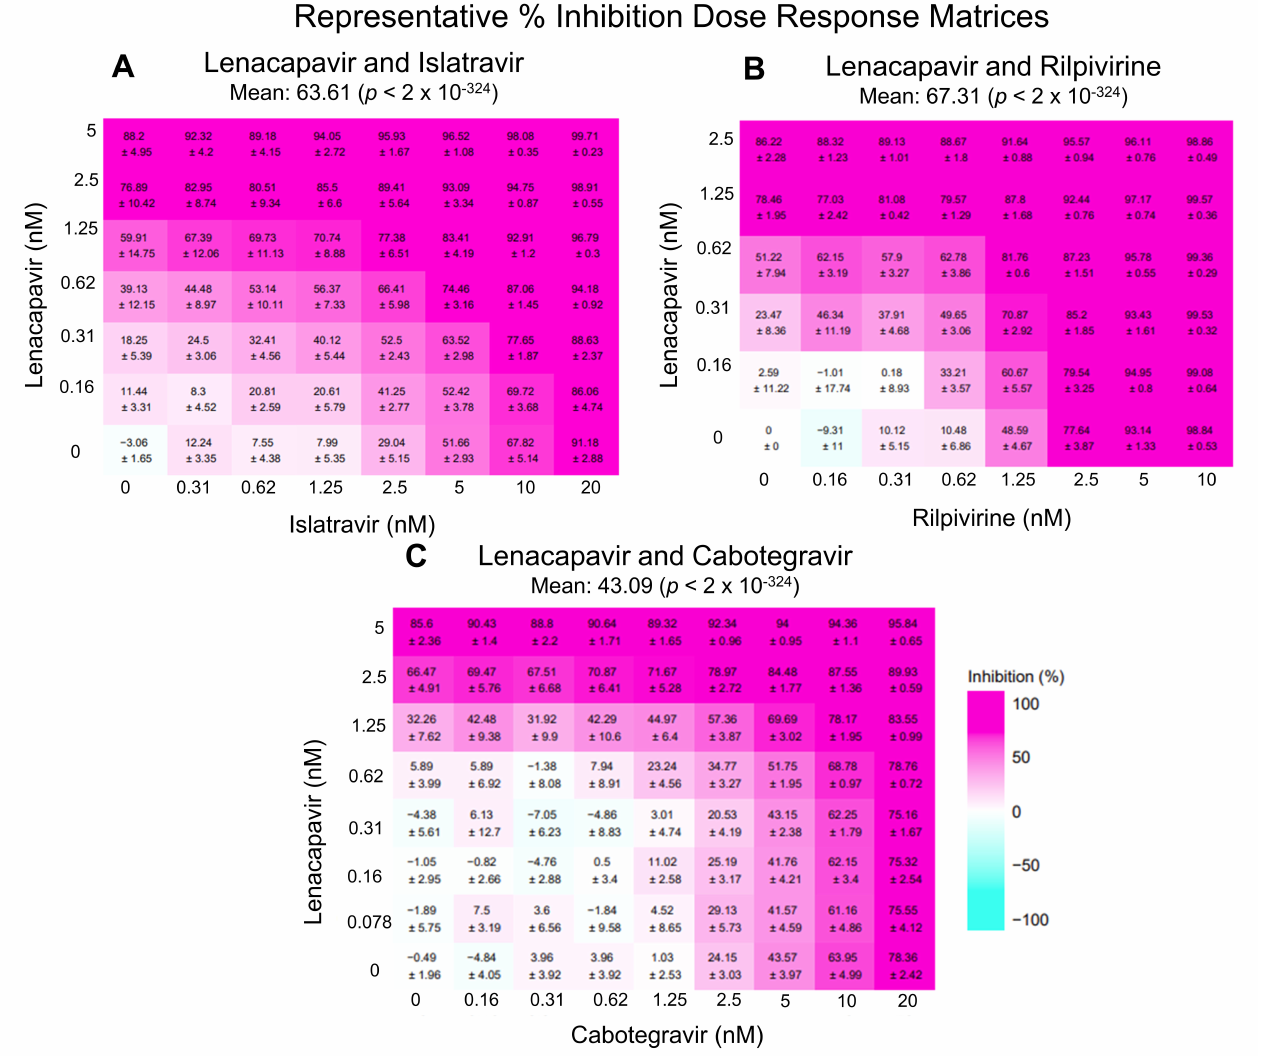
Figure 1. Representative percent inhibition dose response matrix of LEN with ISL, RPV, or CAB. Above demonstrates representative matrices (made with SynergyFinder Plus) of various percent inhibition at each individual dose-response point as well as the overall percent inhibition with the combinations studied: ( A ) LEN and ISL, ( B ) LEN and RPV, and ( C ) LEN and CAB. All negative values are corrected for in SynergyFinder